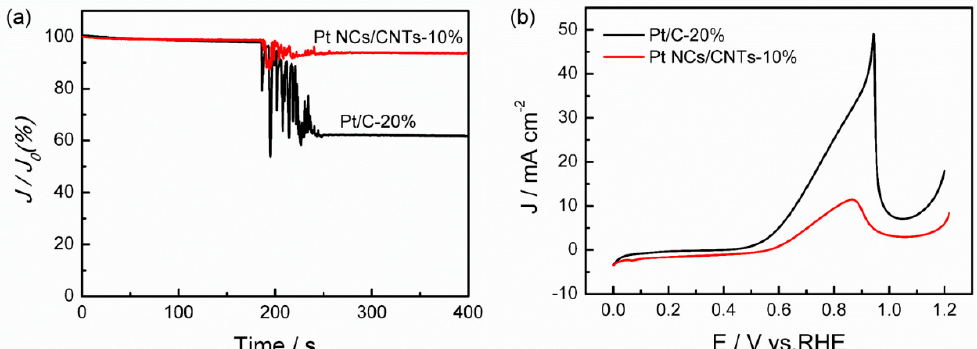
Figure 11. ( a ) Chronoamperometric responses of Pt NCs/CNTs-10% and Pt/C-20% in 0.1 M O 2 -saturated HClO 4 before and after addition of methanol; ( b ) Polarization curves for methanol oxidation on Pt NCs/CNTs-10% and Pt/C-20% catalysts in 0.1 M HClO 4 and 0.5 M CH 3 OH solution saturated with N 2 at scan rate of 10 mV s –1 .